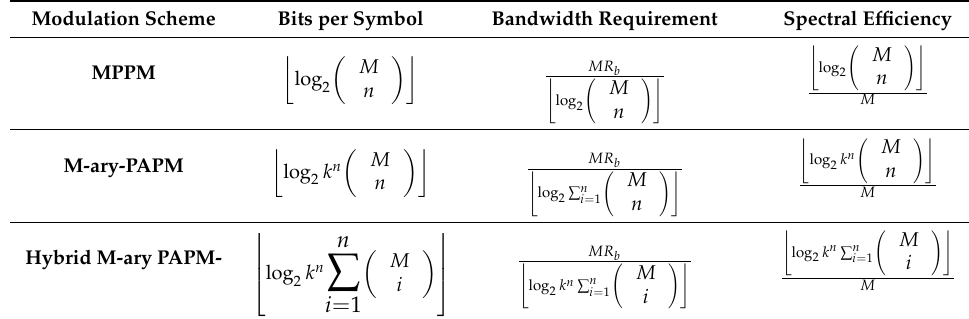
Table 2. The proposed M-ary DPPM-M-PAPM based modulation schemes DWDM-FSO optical fiber communication network system